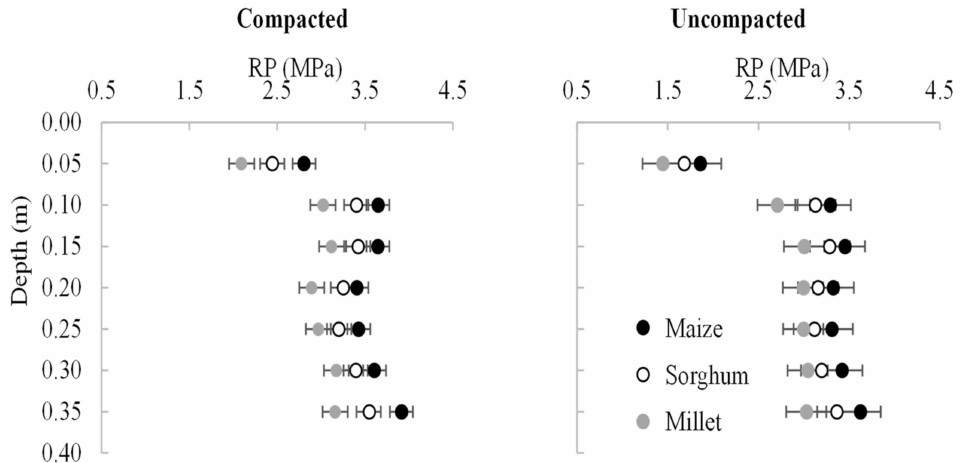
Figure 2. Soil penetration resistance measured in the field after second-season crops of maize, sorghum, and millet in compacted and uncompacted soils. The bars refer to the confidence interval of the mean, and the overlap of the confidence intervals indicates the absence of differences between means ( p ≤